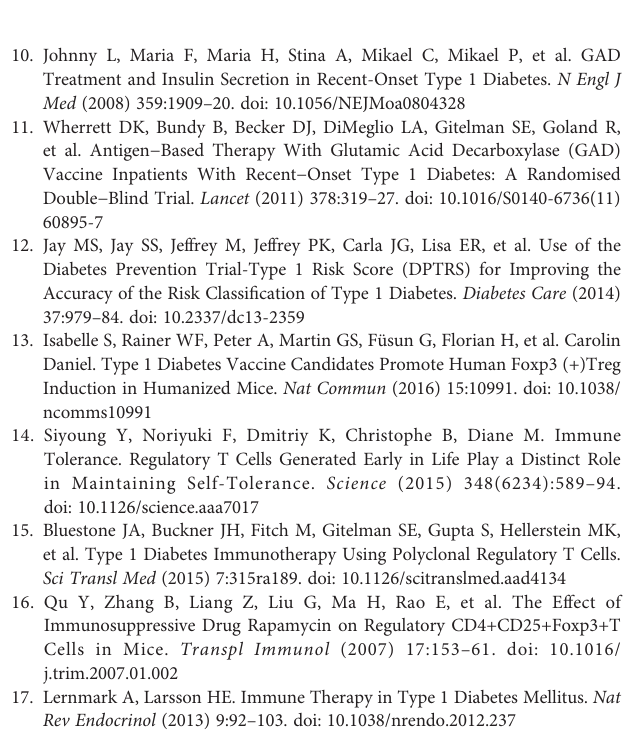
Supplementary Figure 1 | qRT-PCR results. (A) MircoRNAs (B) mRNAs. Supplementary Figure 2 | Analysis of microRNA/mRNA expression pro fi les in spleen lymphocytes of Balb/C mice stimulated with Kyn in vitro compared with the negative control group (NC). (A, C) Volcano plots show the differentially expressed miRNAs/mRNAs. (B, D) Hierarchical clustering presents the correlation of different samples. Supplementary Figure 3 | Immune related miRNA – mRNA-pathway. Global analysis of immune related miRNA and mRNA which were enriched in both up and down pathways. Supplementary Table 1 | The primers sequence used for q-PCR. Supplementary Table 2 | Differentially expressed miRNA result. Supplementary Table 3 | Differentially expressed mRNA result. Supplementary Table 4 | Gene Ontology analysis for the target gene of differentially expressed miRNA. Supplementary Table 5 | KEGG pathway analysis for the target gene of differentially expressed